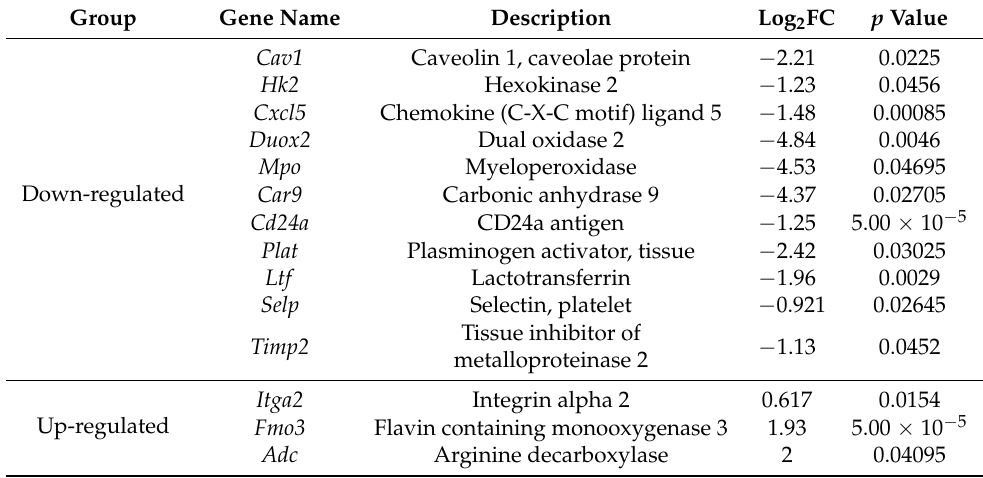
Table 1. Representative differentially expressed genes in the PEMF + LPS group versus the LPS